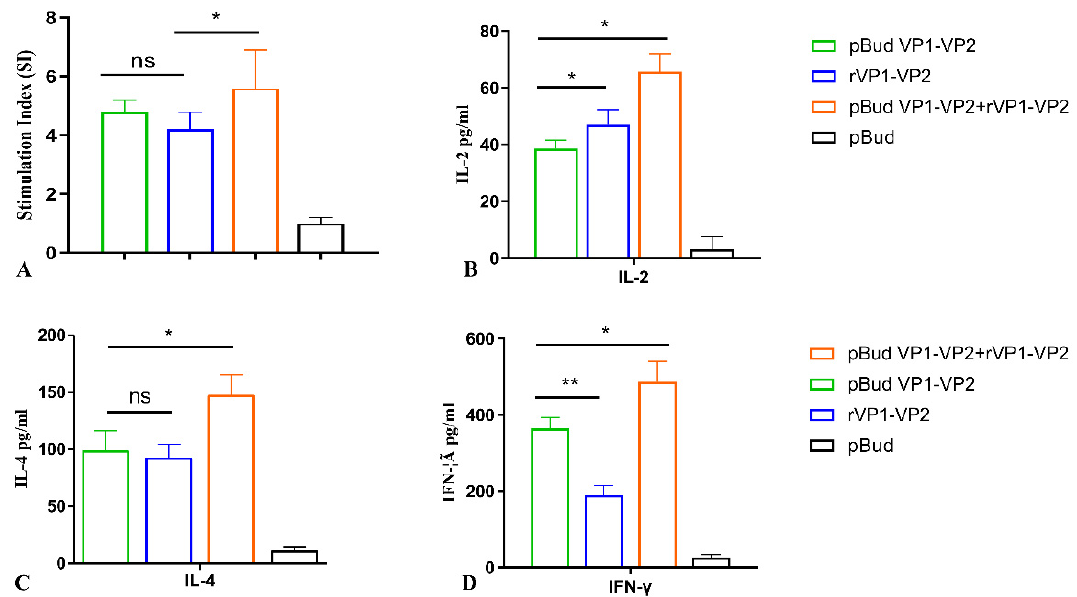
Figure 5. Detection of SI index of splenic lymphocytes and expression levels of IL-2, IL6, and IFN- γ in vitro. ( A ): SI index of splenic lymphocytes stimulated with VP1 protein in vitro. ( B ): Expression levels of IL-2 of spleen lymphocytes stimulated with VP1 protein in vitro. ( C ): Expression levels of IL-6 of spleen lymphocytes stimulated with VP1 protein in vitro. ( D ): Expression levels of IFN- γ of spleen lymphocytes stimulated with VP1 protein in vitro. Differences were considered significant when p ≤ 0.05 (*) and highly significant when p ≤ 0.01 (**); the error bars represent the SEM; ns, no significant difference ( p > 0.05). Table 4. Hematocrit value (Hct) after CIAV challenge.